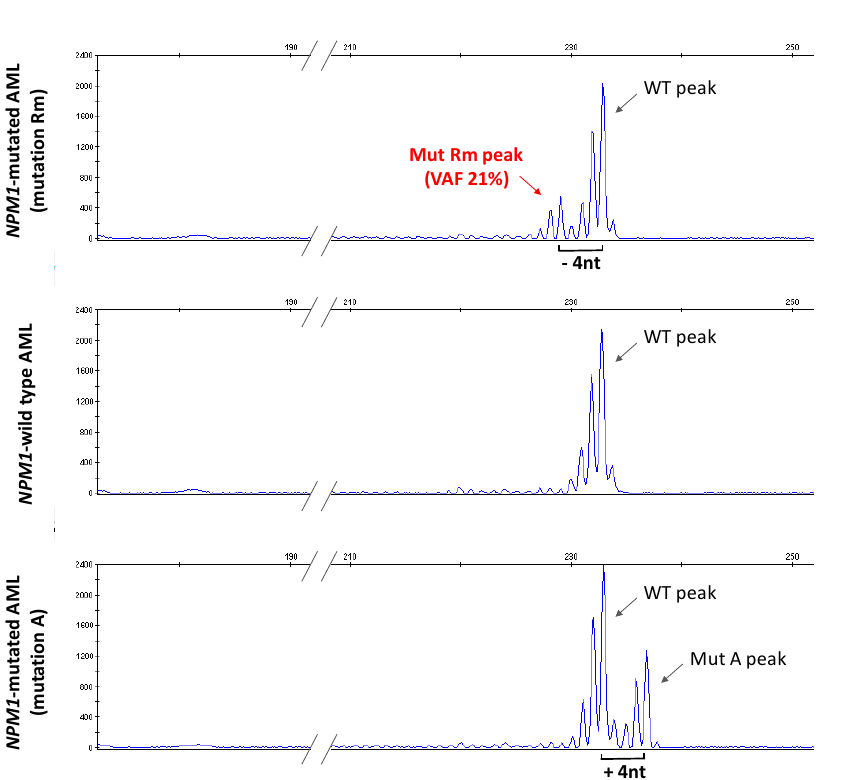
Figure 3. Genomic DNA NPM1 fragment analysis. Electropherograms of genomic DNA fragments of NPM1 exon 12 extracted from PB of the AML patient Rm (upper panel), AML sample with wild type NPM1 (middle panel) and AML sample with NPM1 mutation A (lower panel). Peaks corresponding to WT (wild type), mutant A (Mut A) and mutant Rm (Mut Rm) are indicated. Fragments from Mut Rm are 4 nucleotides shorter (−4nt) than WT. Fragments from Mut A are 4 nucleotides longer (+4nt) than WT. The variant allelic frequency (VAF) of the Rm mutated allele is shown.